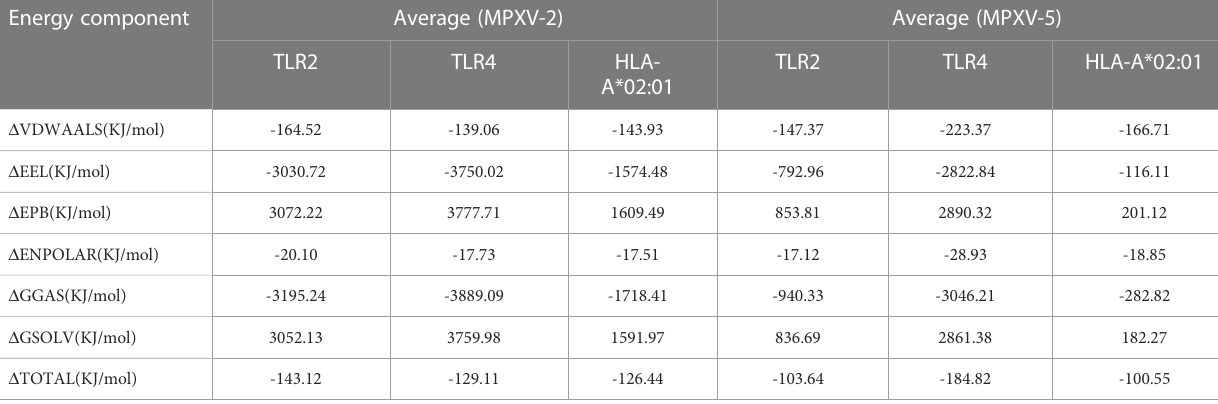
MPXV-5) and C1. The primary response in the three simulations were both characterized by elevated immunoglobulin IgM (Figure 9A; Supplementary Figure 9A), B cells (isotype: lgM) (Figure 9B; Supplementary Figure 9B) and plasma cells (isotype: lgM) (Supplementary Figure 9C). In secondary and tertiary TABLE 6 MM-PBSA calculations of vaccines-receptors complexes. Energy